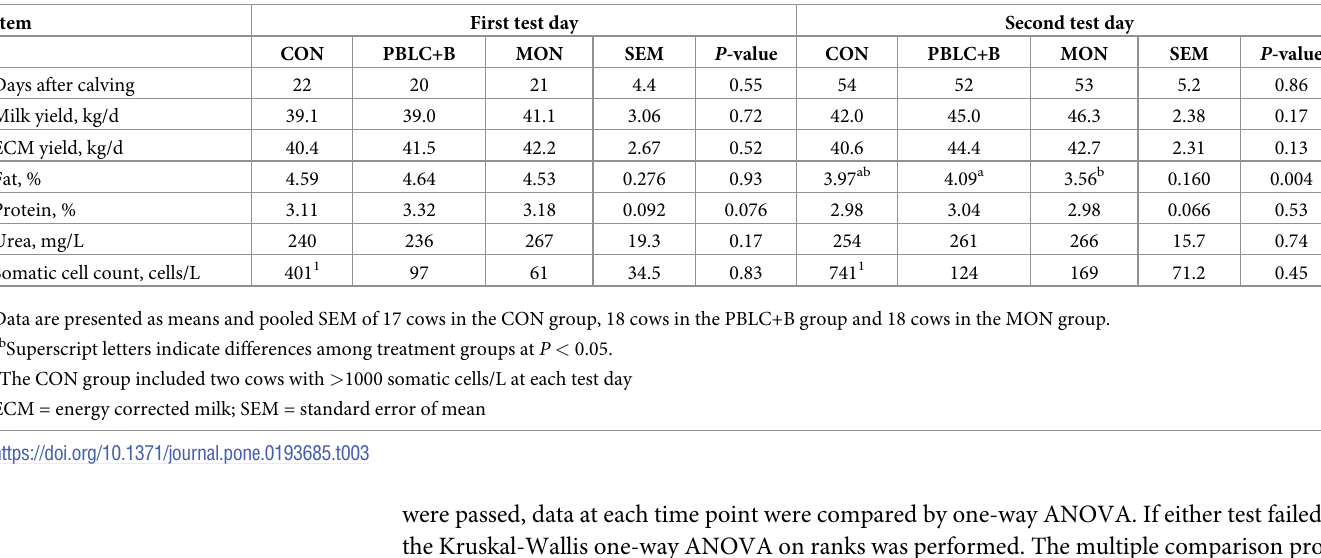
Table 3. Milk performance on herd test days of cows receiving plant bioactive lipid compounds and biotin (PBLC+B) from d -21 to 37 relative to parturition, cows receiving a monensin bolus (MON) at d -21 or cows receiving no such supplements